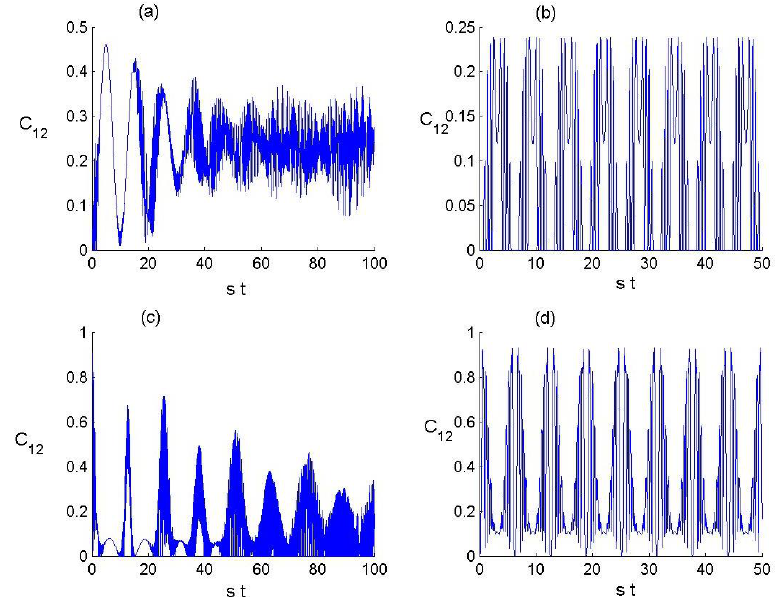
Figure 3. Time evolution of the TQS entanglement denoted by 𝐶 12 . Panels ( a , b ) correspond to the case of absence of the PDP effect (i.e., 𝜆 = 0) for constant (𝐷(t) = s) and t-dc ( 𝐷(t) = s sin(t)) , re- spectively. Panels ( c , d ) are, respectively, the same as ( a ) and ( b ) but in the presence of the PDP effect with 𝜆 = 50 .